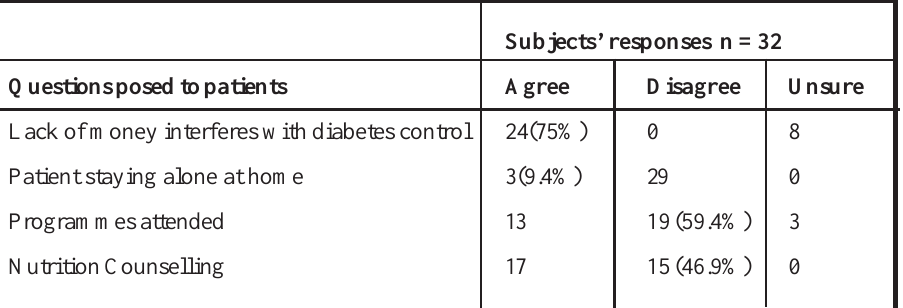
Table 1: Factors contributing to poor glycaemia